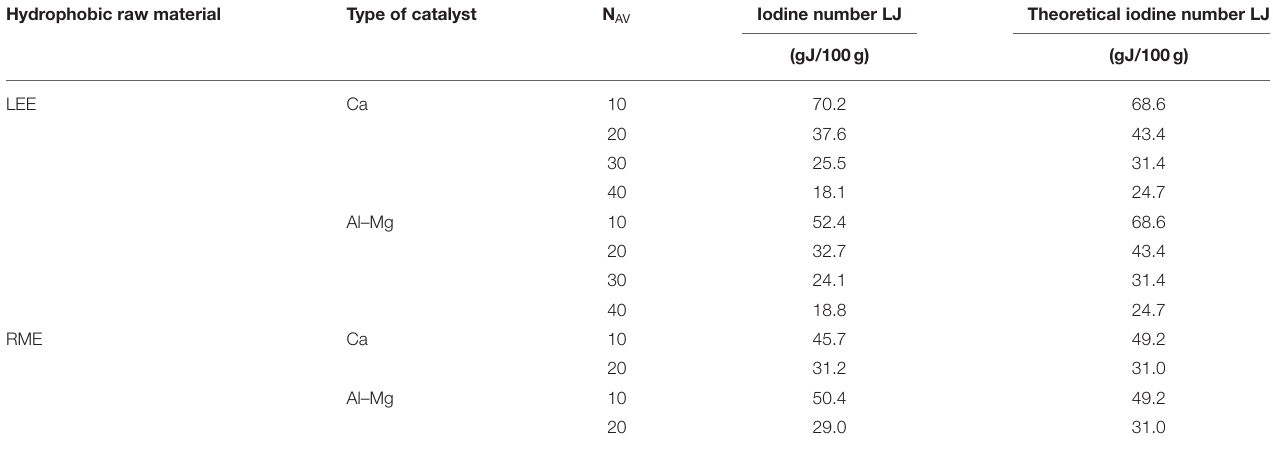
TABLE 5 | Analysis of the degree of unsaturation of ethoxylated fatty acid ethyl and methyl esters. Hydrophobic raw